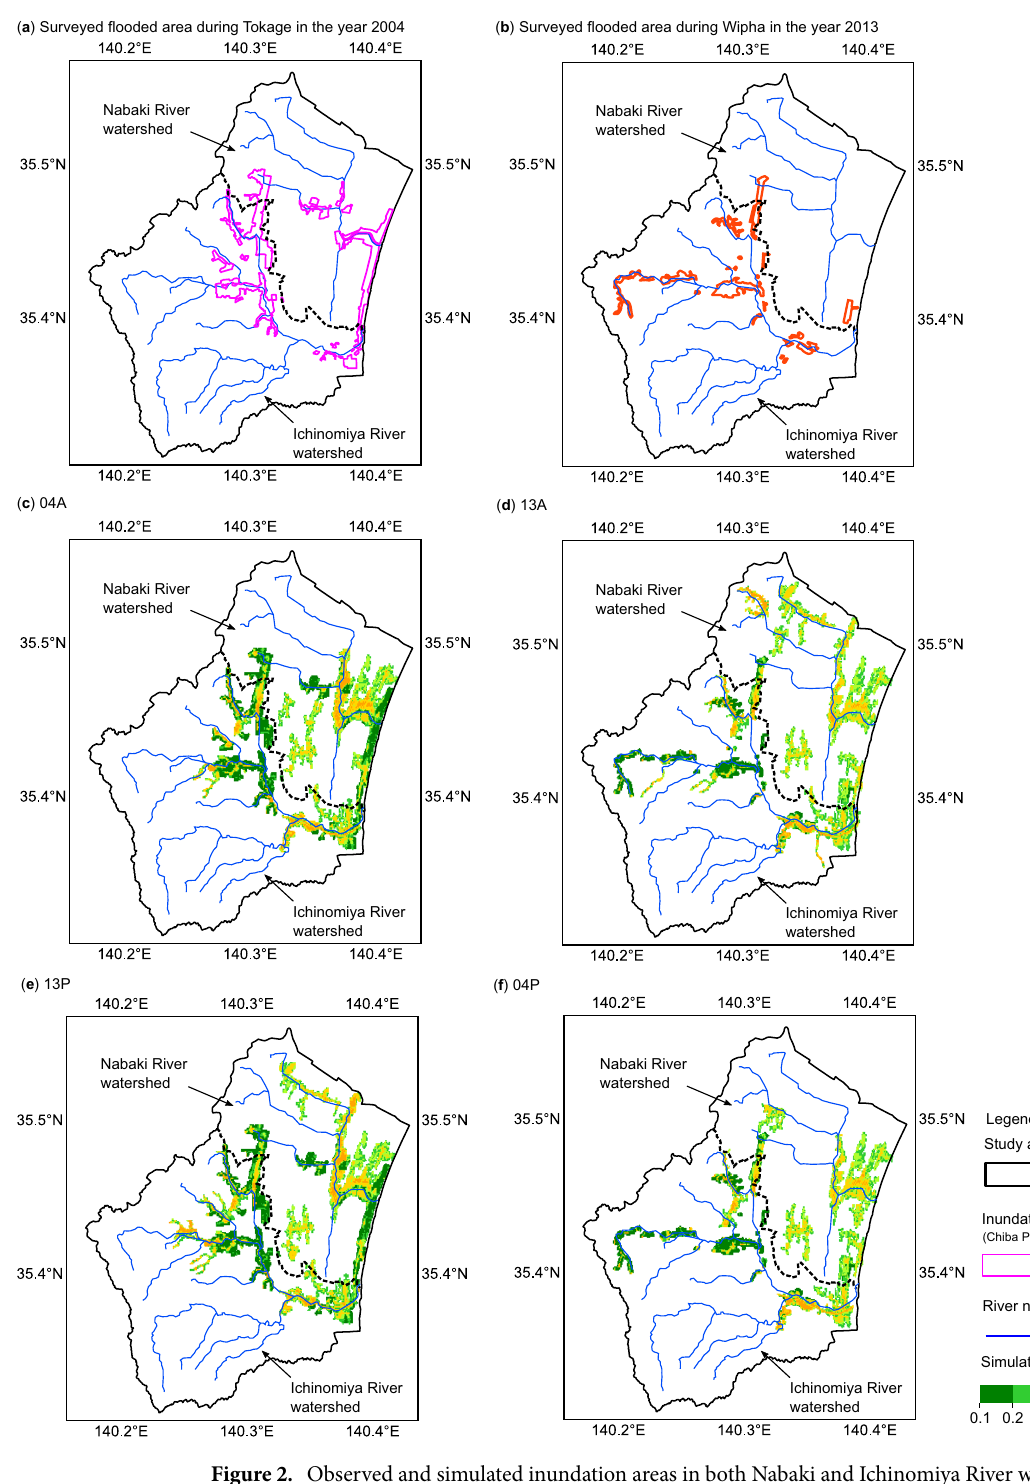
Figure 2. Observed and simulated inundation areas in both Nabaki and Ichinomiya River watersheds for four scenarios. The regions surrounded by magenta lines in ( a ) were the reported flooded areas in the year 2004 (Ref. 42 ), and those surrounded by the orange lines in ( b ) were the surveyed flooded areas mainly in the Ichinomiya River watershed at the flood event in the year 2013 (Ref. 43 ). ( c ) 04A and ( d ) 13A were employed to compare the calculated flooded areas with the observed ones. ( e ) 13P and ( f ) 04P were conducted to quantify the influence of land surface elevation changes on the spatial features of the inundation areas. The boundary of river watersheds is based on Dutta et al. 18 . (Figure generated using Matplotlib v. 2.2.3, http://www.matpl otlib